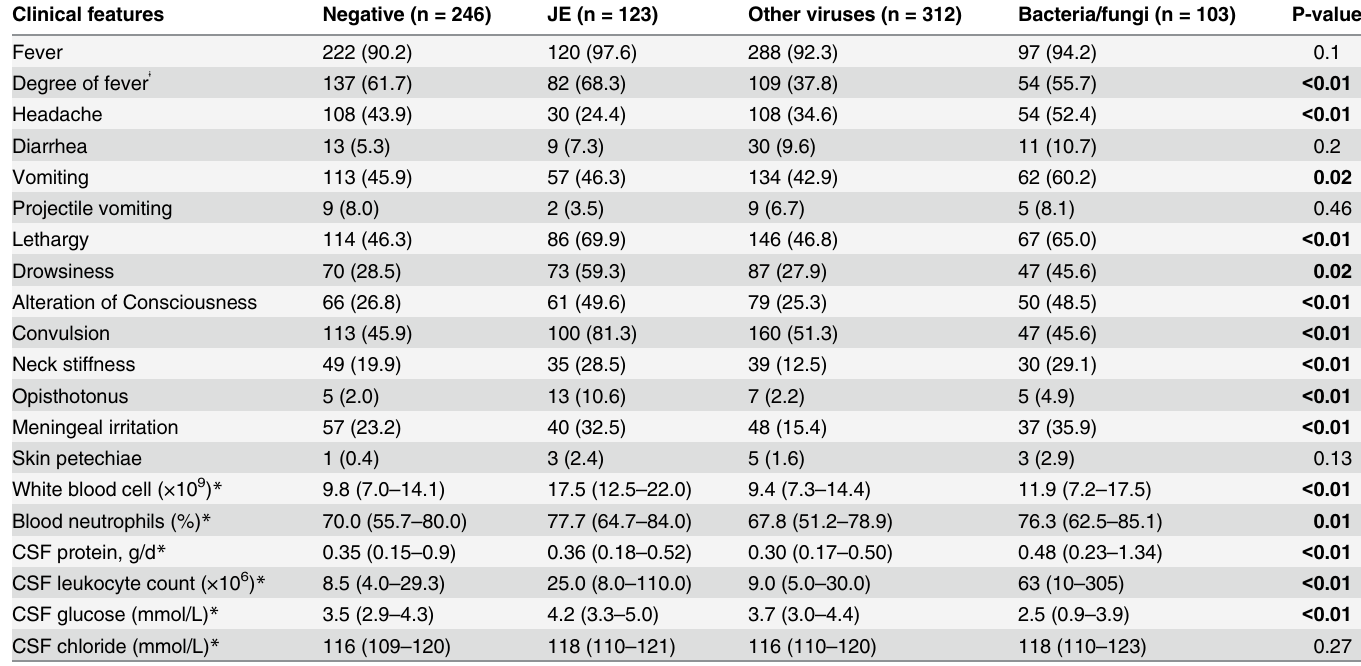
Table 4. Comparison of clinical features of negative group, Japanese encephalitis, other viral encephalitis and bacterial meningitis in Guigang City, Guangxi, May 2007- June